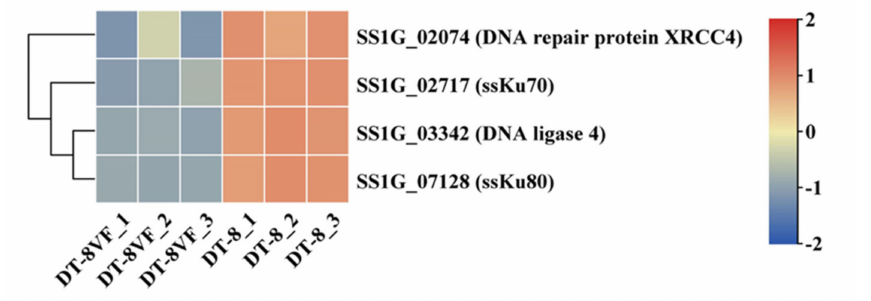
Figure 4. The expression profiles of the key NHEJ genes.